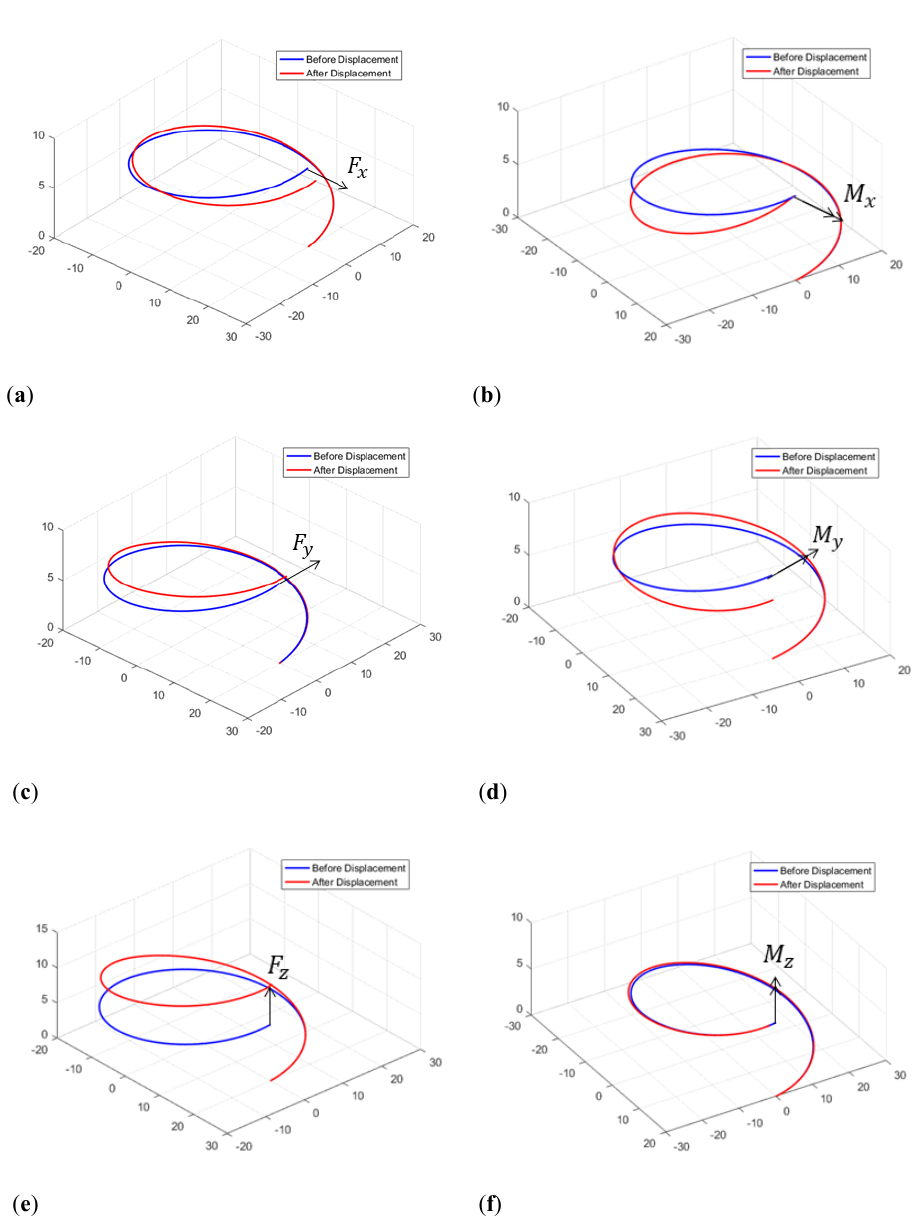
Figure 4. Direction-displacement graphs for load conditions ( a ) F x , ( b ) M x , ( c ) F y , ( d ) M y , ( e ) F z , ( f ) and M z .